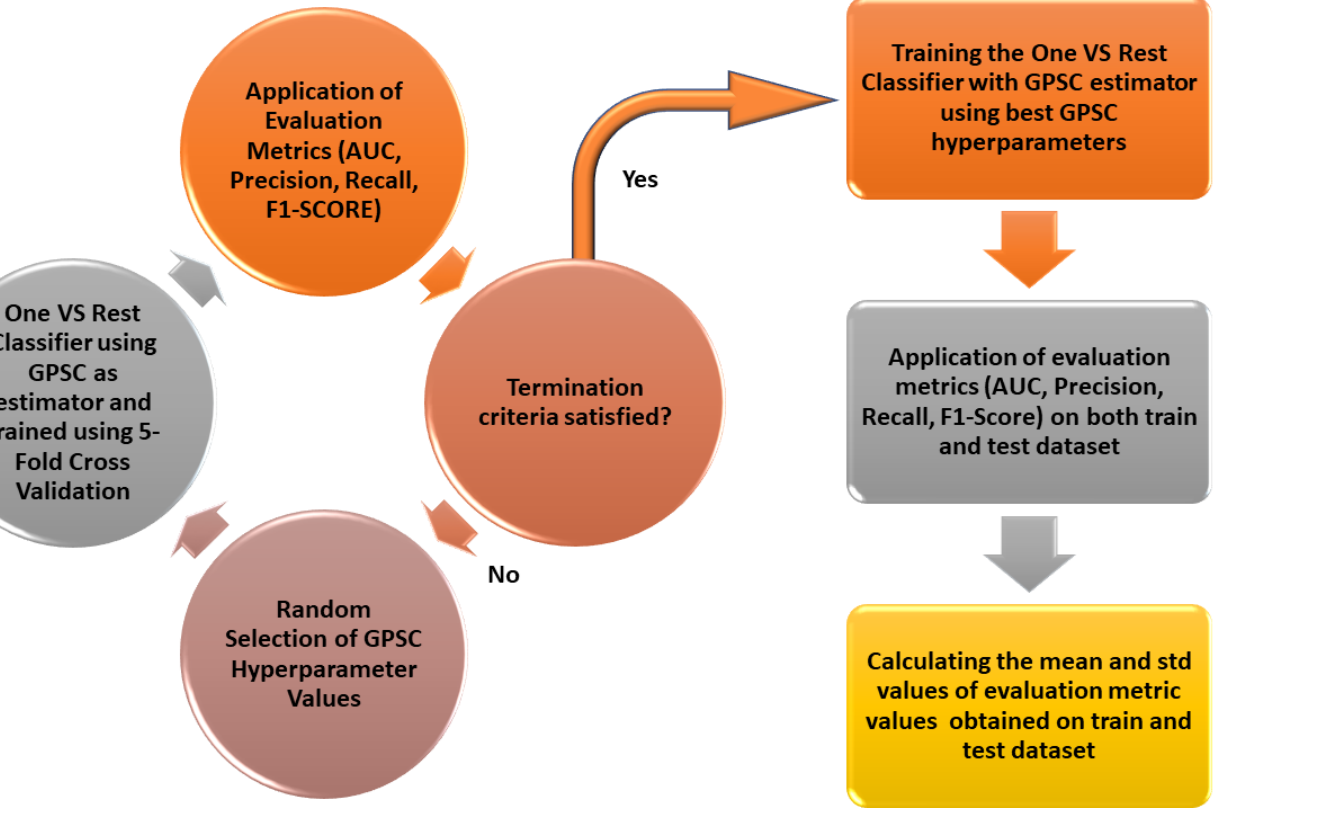
Figure 9. The procedure of performing GPSC with random hyperparameter search with 5-fold